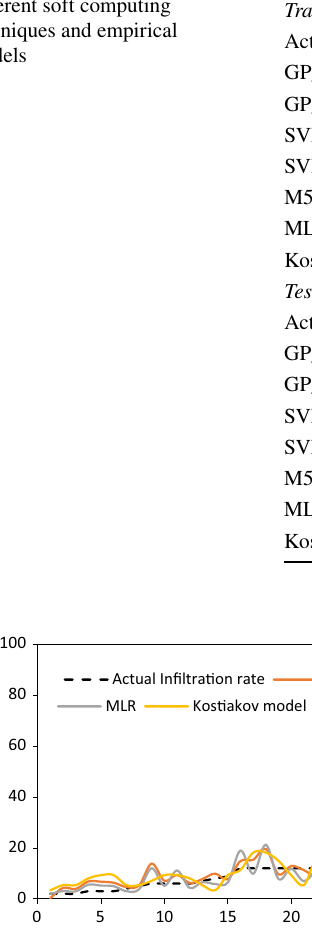
Table 6 Statistical information of the infiltration rate with different soft computing techniques and empirical models